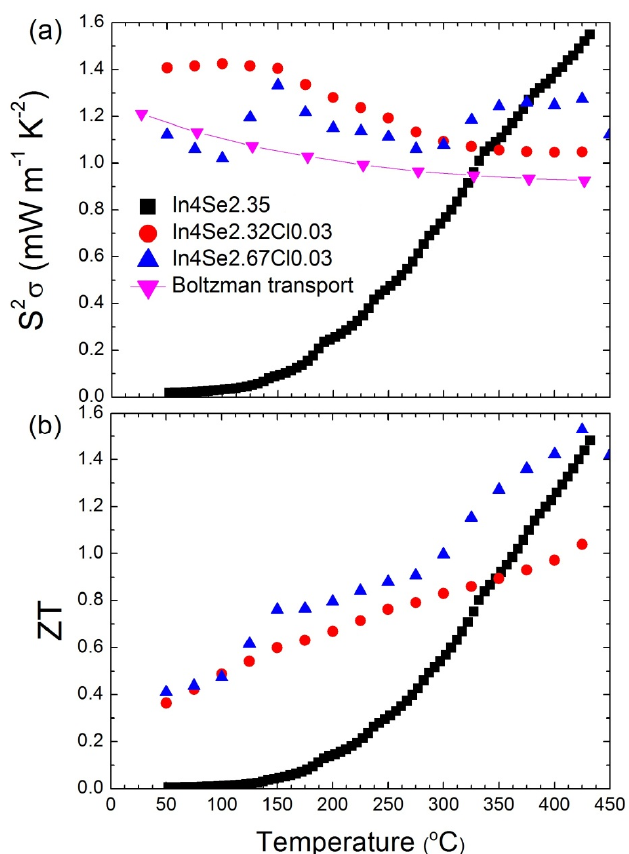
Figure 14. Temperature-dependent ( a ) power factor and ( b ) ZT value for In 4 Se 2.35 [15], In 4 Se 2.32 Cl 0.03 , and In 4 Se 2.67 Cl 0.03 bulk crystals [29]. Reproduced with permission from WILEY-VCH Verlag GmbH & Co., 2011